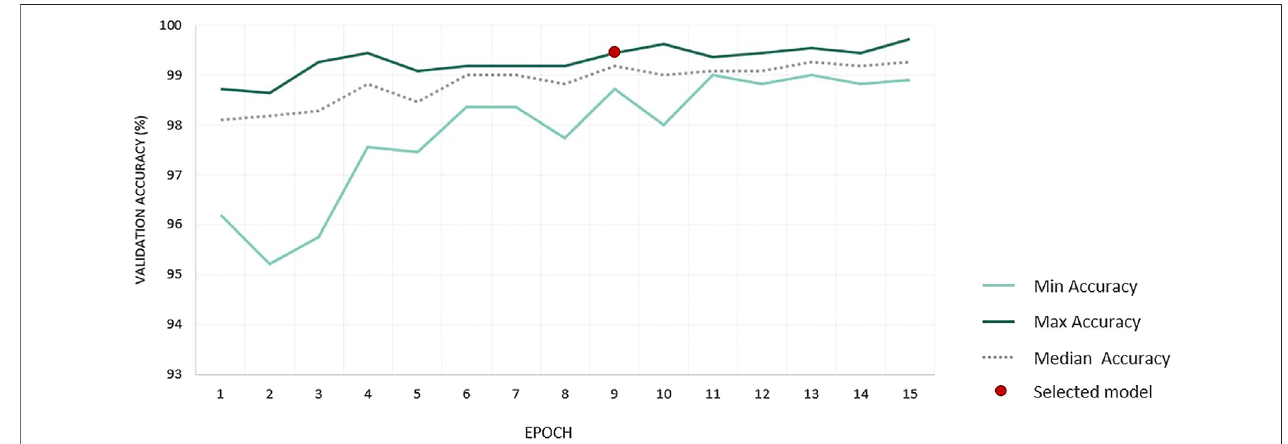
FIGURE 4 | Summary of accuracy values obtained on the validation dataset for the 10 runs.